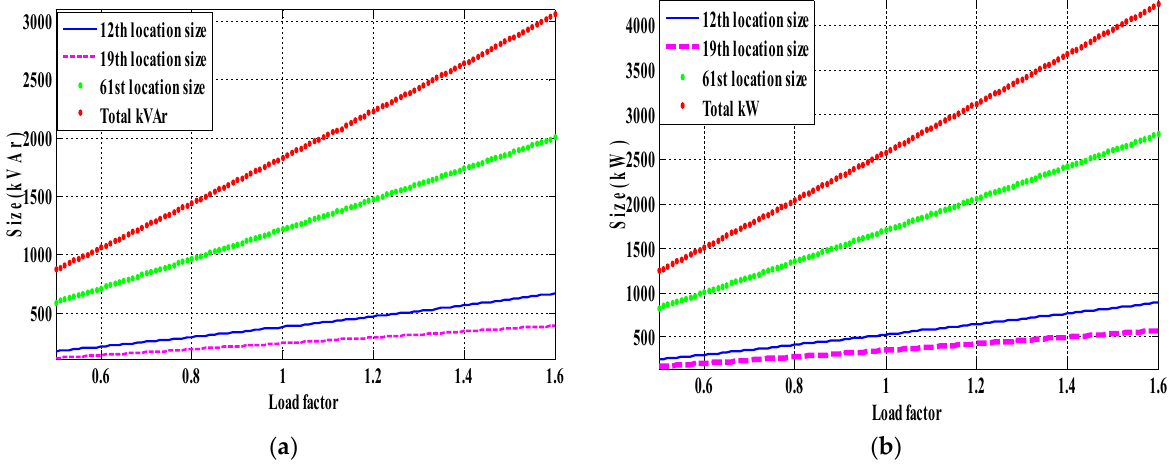
Figure 10. ( a ) Optimum kVAr for capacitor under various load factors (IEEE 69-Bus). ( b ) Optimum kW for DG under various load factors (IEEE 69-Bus).